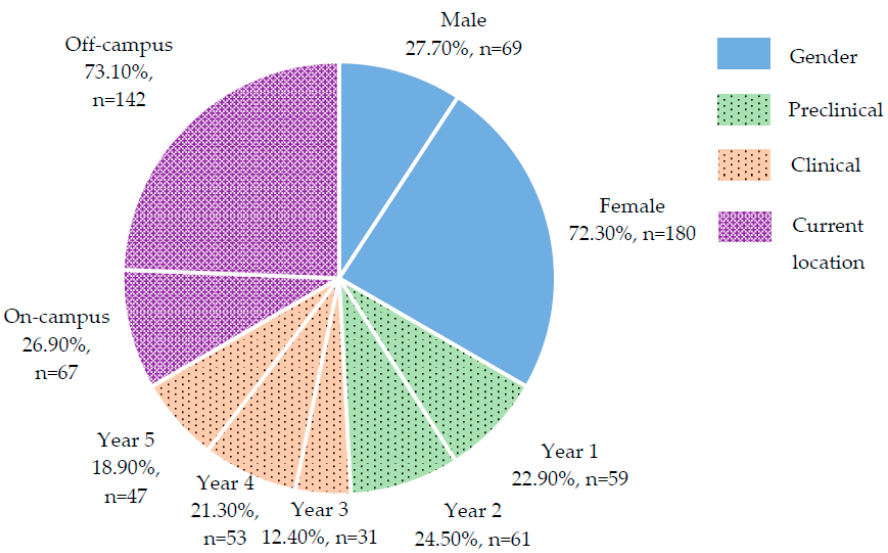
Figure 1. Sociodemographic background.